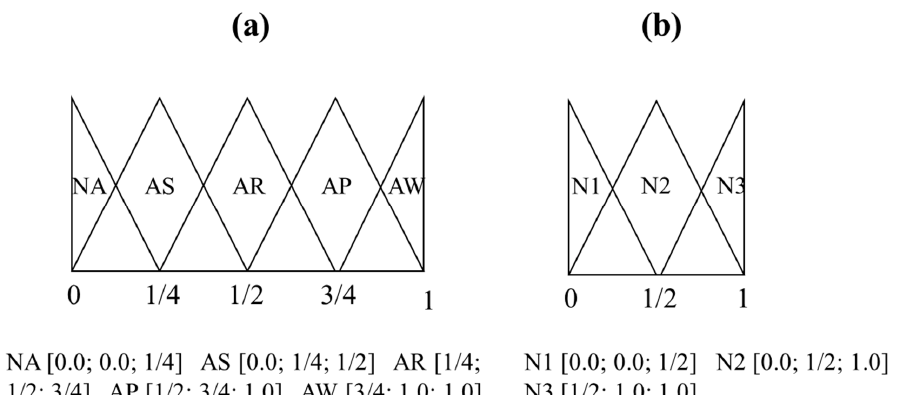
Figure 1. ( a ) Fuzzy values of the evaluation scale of practices; ( b ) Fuzzy values of the levels for allocation of respondents based on education, experience, and knowledge.